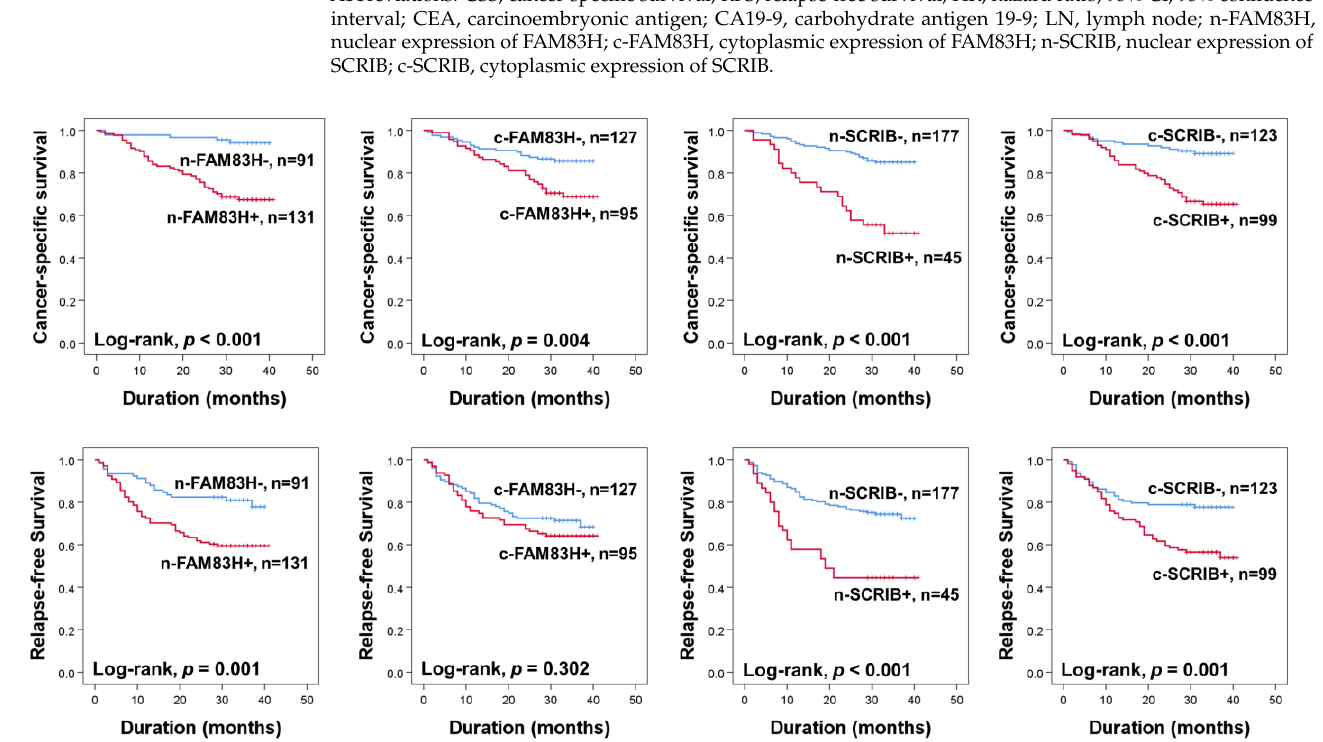
Figure 2. Kaplan–Meier survival analysis for cancer-specific survival and relapse-free survival according to nuclear and cytoplasmic expressions of FAM83H and SCRIB in CRC patients. n- FAM83H, nuclear expression of FAM83H; c-FAM83H, cytoplasmic expression of FAM83H; n-SCRIB, nuclear expression of SCRIB; c-SCRIB, cytoplasmic expression of SCRIB. Multivariate analysis was performed with the factors significantly associated with CSS and RFS: preoperative serum levels of CEA and CA19-9, tumor stage, T category of tumor stage, lymph node metastasis, distant metastasis, and the expressions of n-FAM83H, n-SCRIB, and c-SCRIB. The factors significantly associated with CSS in multivariate analysis were CA19-9 ( p = 0.004), T category of stage ( p = 0.041), distant metastasis ( p < 0.001), and the expressions of n-SCRIB ( p = 0.042), c-SCRIB ( p = 0.033), and n-FAM83H ( p = 0.020) (Table 3). Distant metastasis was the factor significantly associated with RFS in multivariate